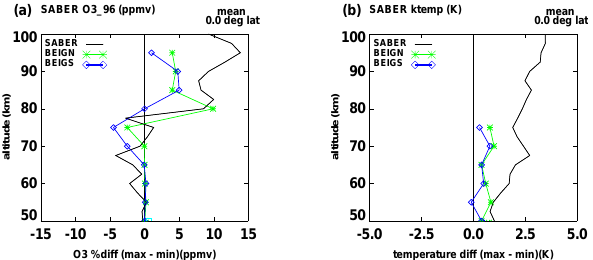
Figure 4. Ozone (left panel) and temperature (right panel) re- sponses to solar activity vs. altitude, from 50 to 100km. Values are responses at solar max − responses at solar min in %(100sfu) − 1 for ozone and K(100sfu) − 1 for temperature. Black lines denote SABER responses at Equator. Green asterisks denote responses based on HALOE by Beig et al. (2012) for 0–30 ◦ N (BEIGN). Blue diamonds denote Beig et al. (2012) for 0–30 ◦ S